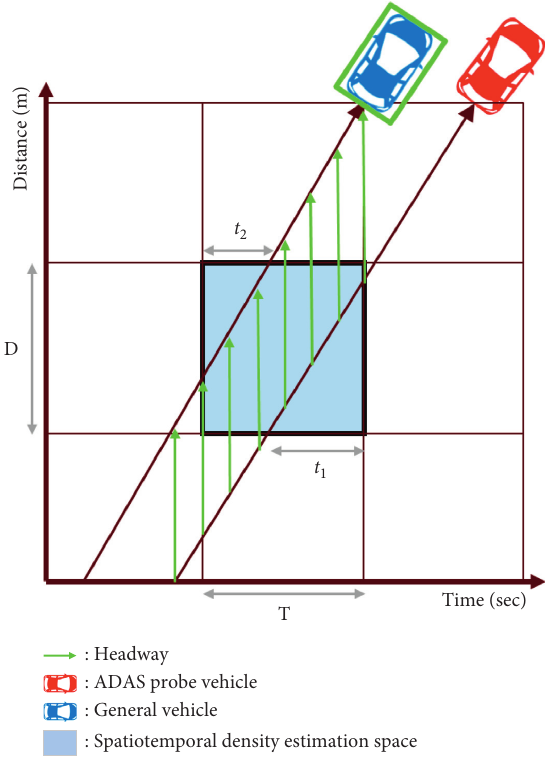
Figure 1: Spatiotemporal traffic density estimation using gener- alized